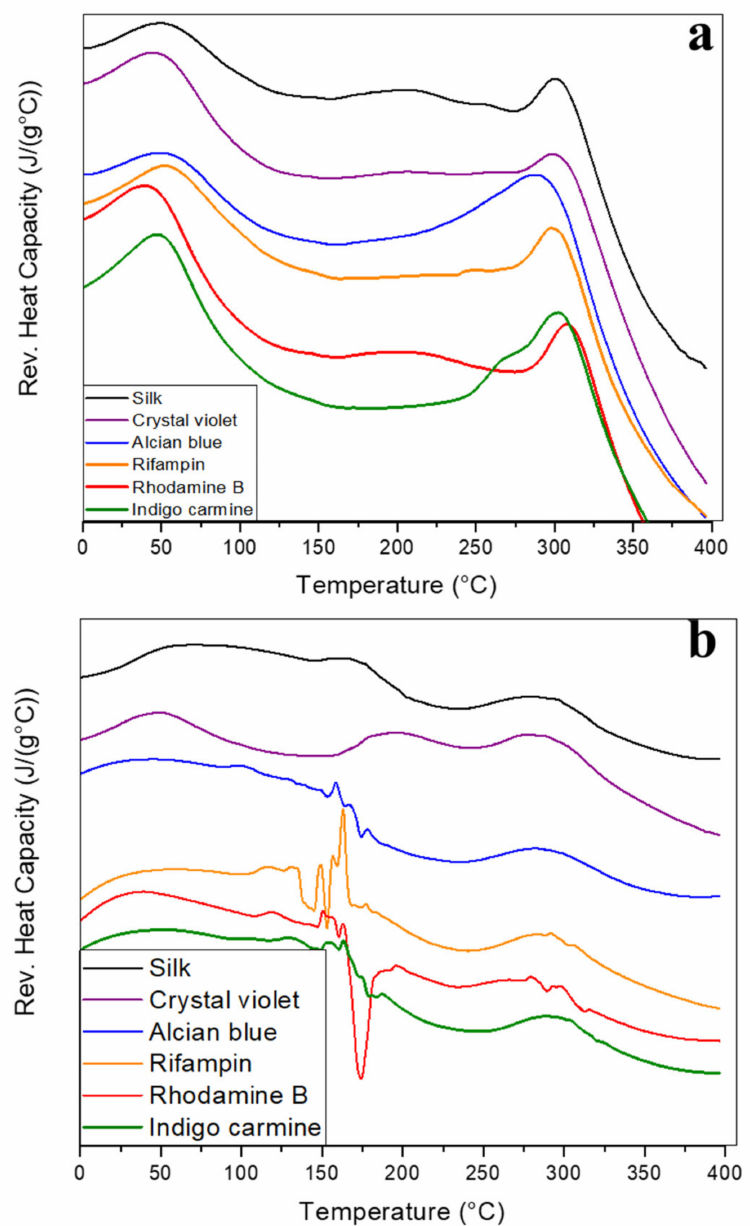
Figure 6. DSC reversing heat capacity thermograms of silk-model drug fibers and films. Reversing heat capacity of silk and silk-model drug ( a ) air-spun fibers and ( b ) thin films. Exothermic is